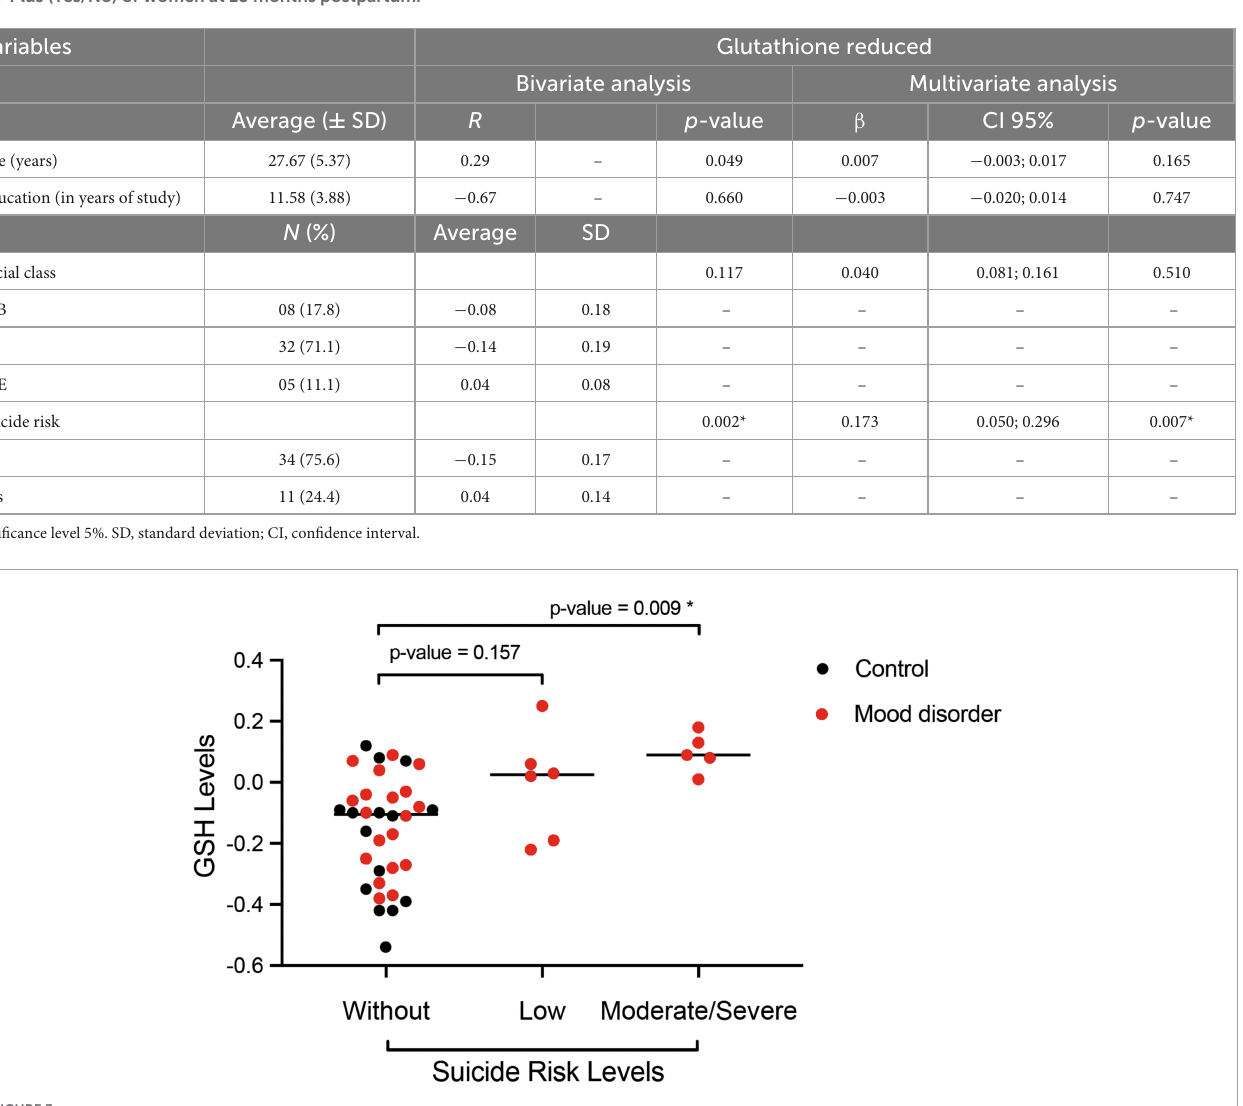
FIGURE3 Post hoc analysis by Bonferroni of the serum glutathione reduced (GSH) level according to the degree of suicide risk classified by MINI-Plus module C (without, low, and moderate/severe risk) of women (control, N = 15 and mood disorder, N = 30) at 18 months postpartum. * p < 0.05 indicates a significant